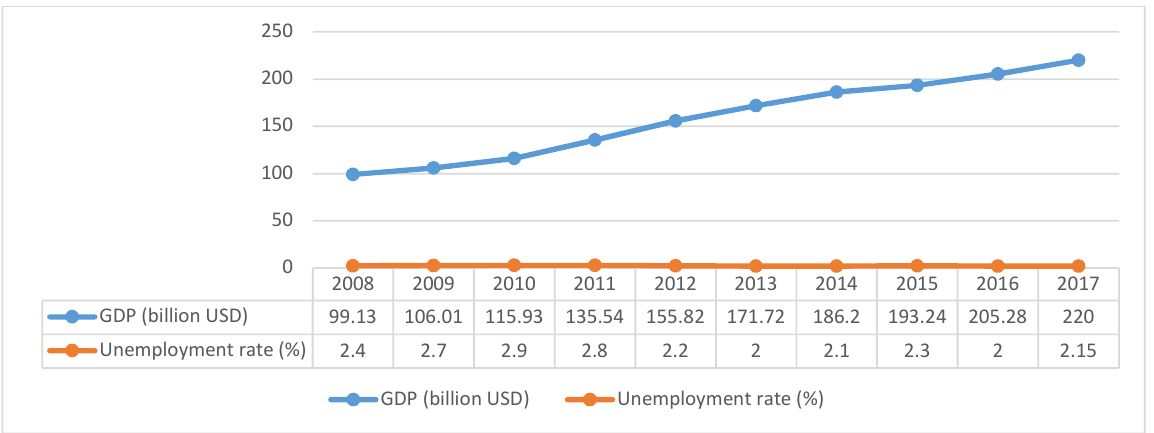
Fig. 1. The trend of GDP and unemployment rate in Vietnam (Source: World bank report